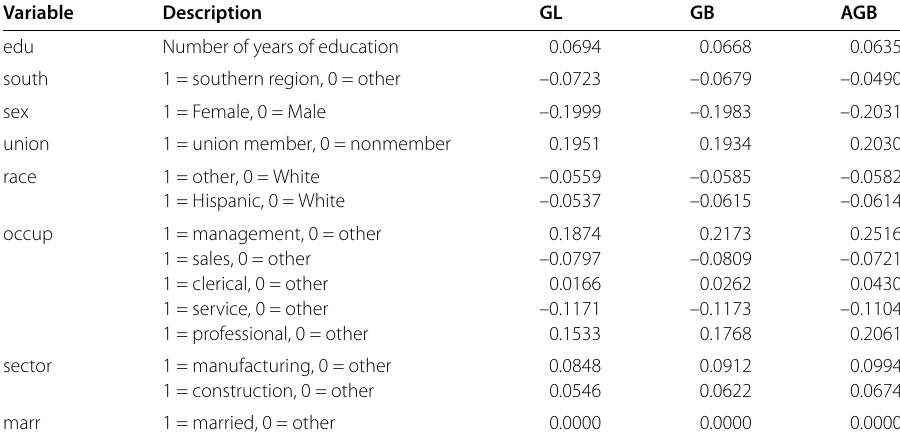
Table 2 Estimates of the wage